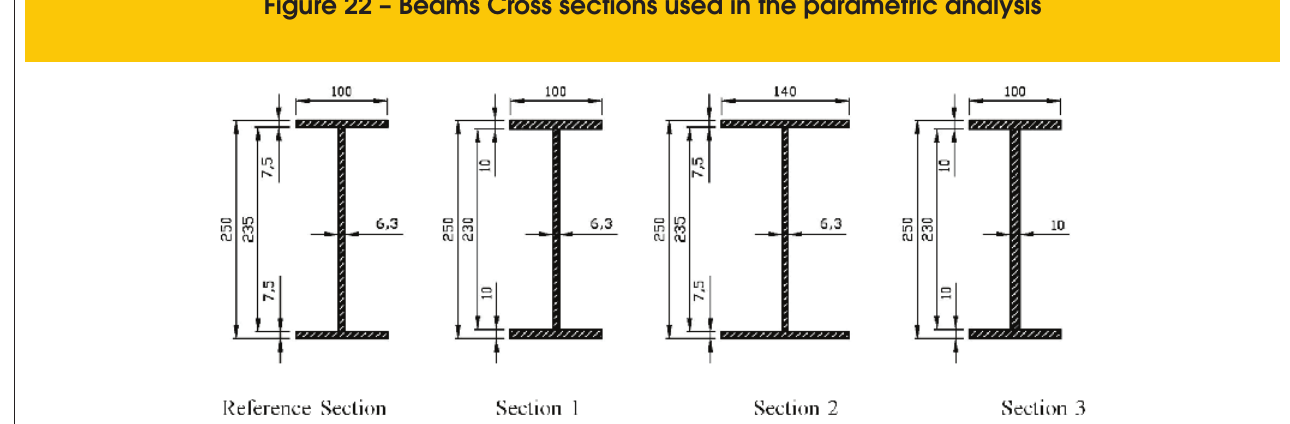
Figure 22 – Beams Cross sections used in the parametric